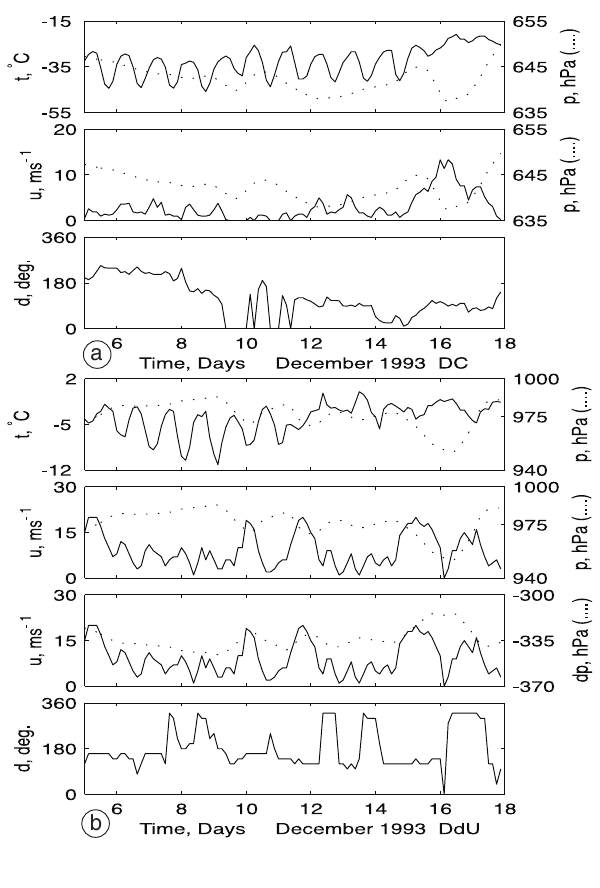
Fig. 10a,b. Time series of meteorological parameters: a) for Dome C showing a strong wind event around 16 December 1993; b) for Dumont d’Urville depicting strong wind events around 10, 12, 15 and 17 December 1993,